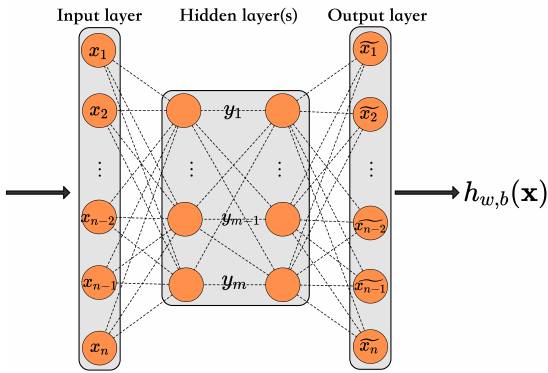
Figure 4. Vanilla